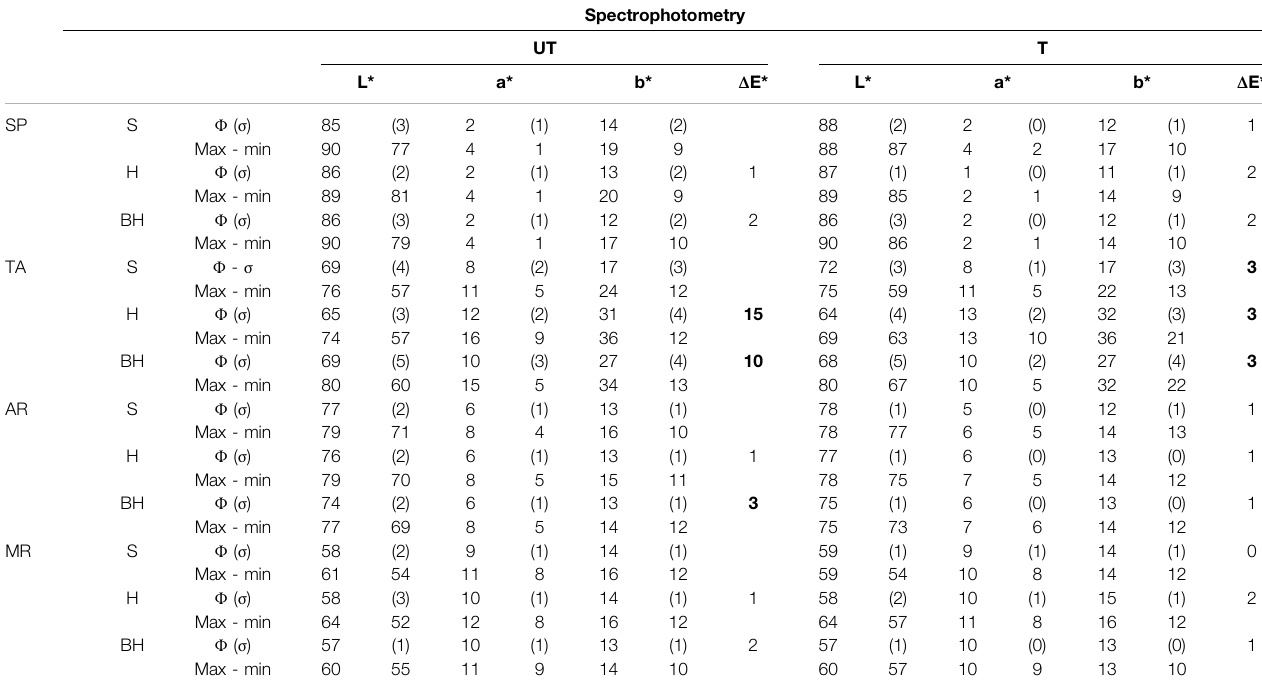
TABLE 1 | Spectrophotometry results for untreated (UT) and treated samples (T) of Calcarenita de Santa Pudia (SP), Travertino Amarillo (TA), Arenisca Ronda (AR) and MolinazaRoja(MR)withsaw-cut(S),honed(H)andbush-hammered(BH)surface fi nishes.Legend:L*,lightness;a*andb*,chromaticparameters; Δ E*:colordifference. The mean value ( Φ ) and its standard deviation ( σ ) and the maximum (Max) and minimum (min) values were obtained by taking 20 measurements for each surface fi nish. Δ E* values of 3 units or more are highlighted in bold type.